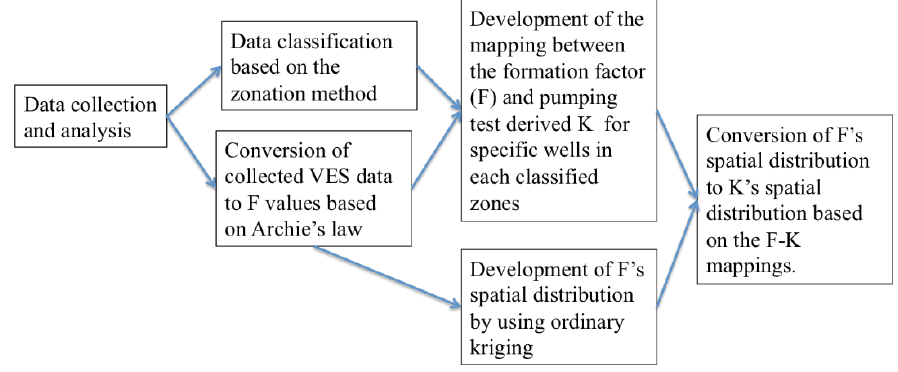
Figure 3. Research procedure.